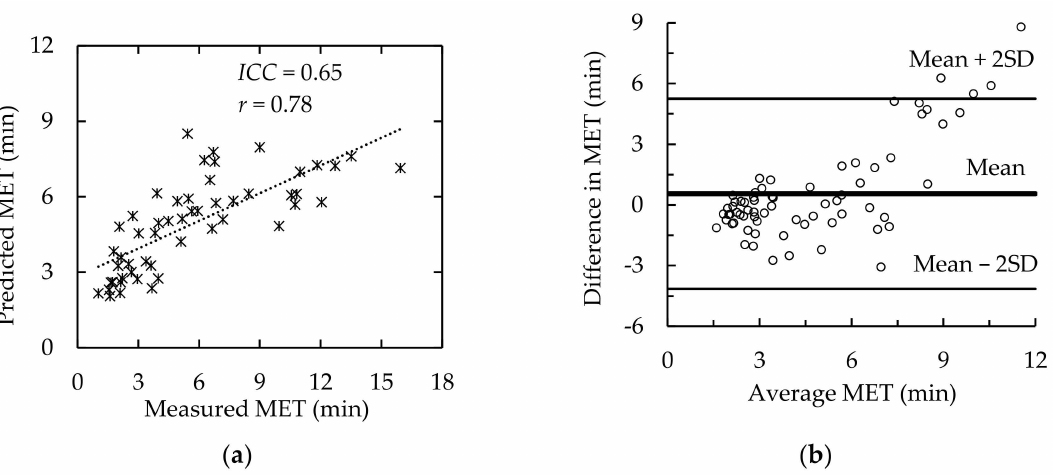
Figure 5. Comparison of measured and predicted MET. ( a ) ICC and r , ( b ) Bland–Altman agreement analysis. Difference in MET = Measured MET–Predicted MET; Average MET = (Measured MET + Predicted MET)/2.